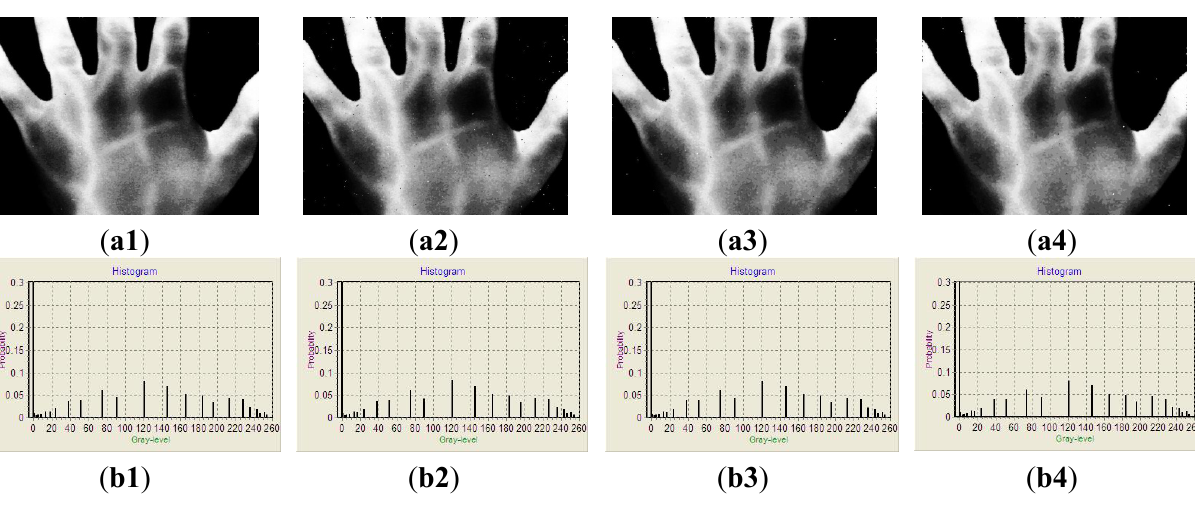
Figure 5. The results enhanced by HCHE. ( a1 – a4 ) show the results of Figure 3(b1–b4) enhanced by HCHE, respectively; ( b1 – b4 ) show the histograms of (a1–a4), respectively; ( c1 – c4 ) show the results of Figure 3(d1–d4) enhanced by HCHE, respectively; ( d1 – d4 ) show the histograms of (c1–c4), respectively; ( e1 – e4 ) show the results of Figure 3(f1–f4) enhanced by HCHE, respectively; ( f1 – f4 ) show the histograms of (e1–e4), respectively; ( g1 – g4 ) show the results of Figure 3(h1–h4) enhanced by HCHE, respectively; ( h1 – h4 ) show the histograms of (g1–g4),